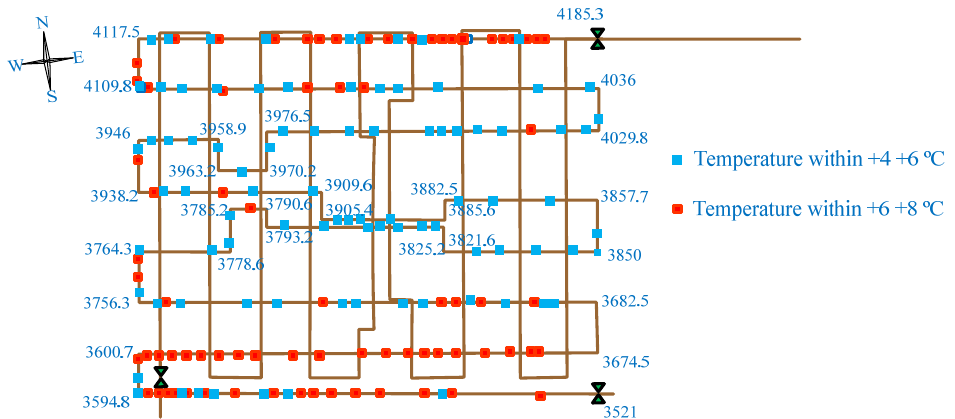
Figure 8. Temperature field distribution in block R.